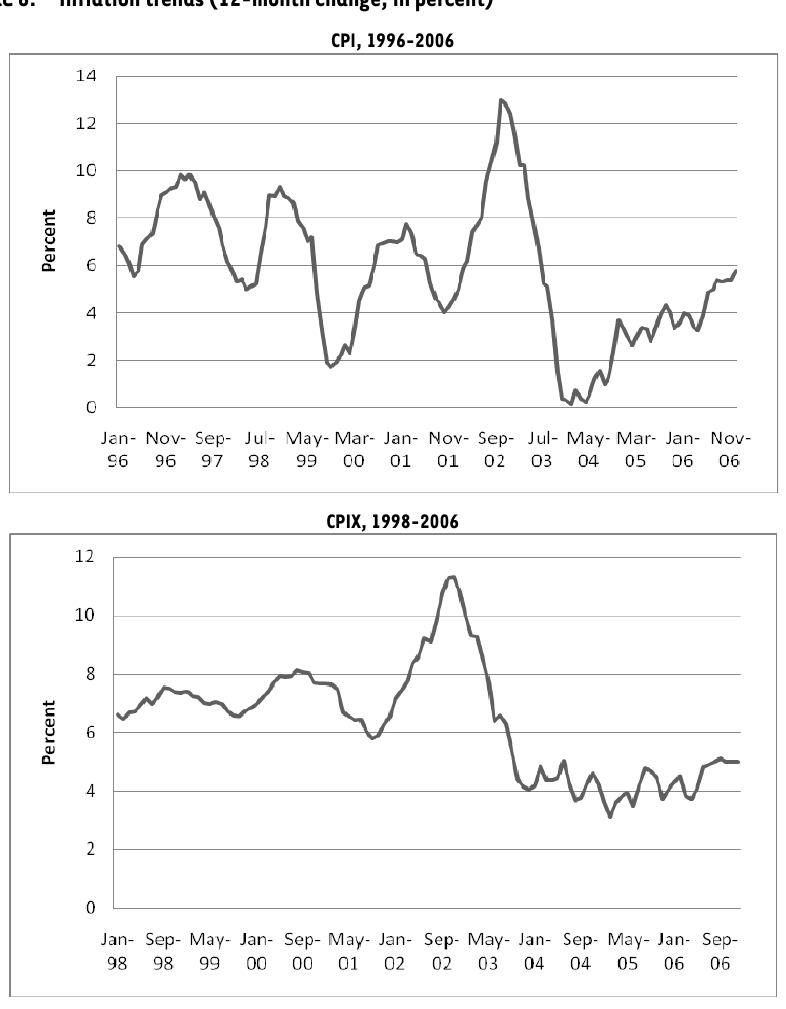
FIGURE 6: Inflation trends (12-month change, in